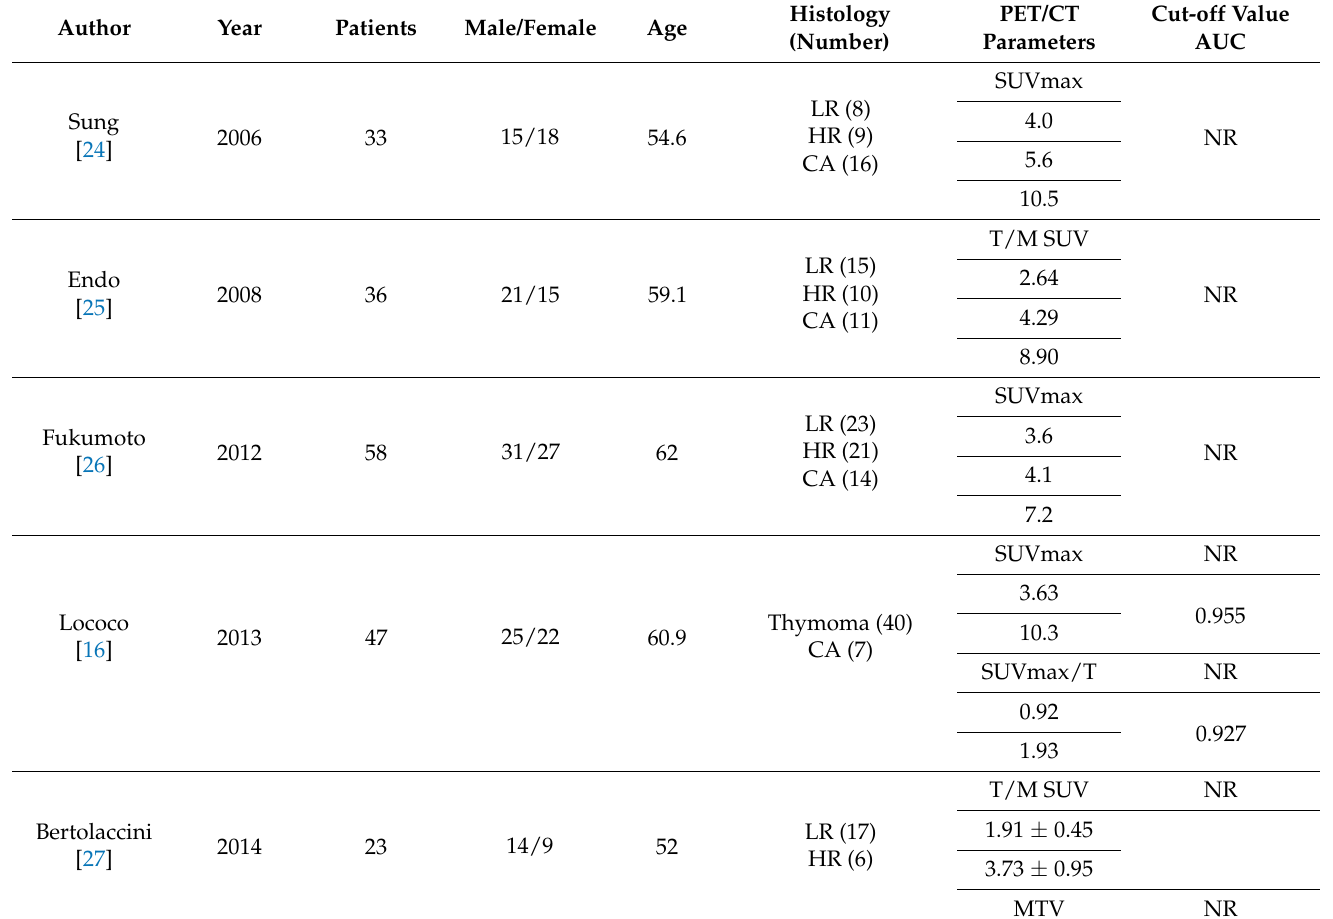
Table 2. Relationship between PET/CT findings and TET